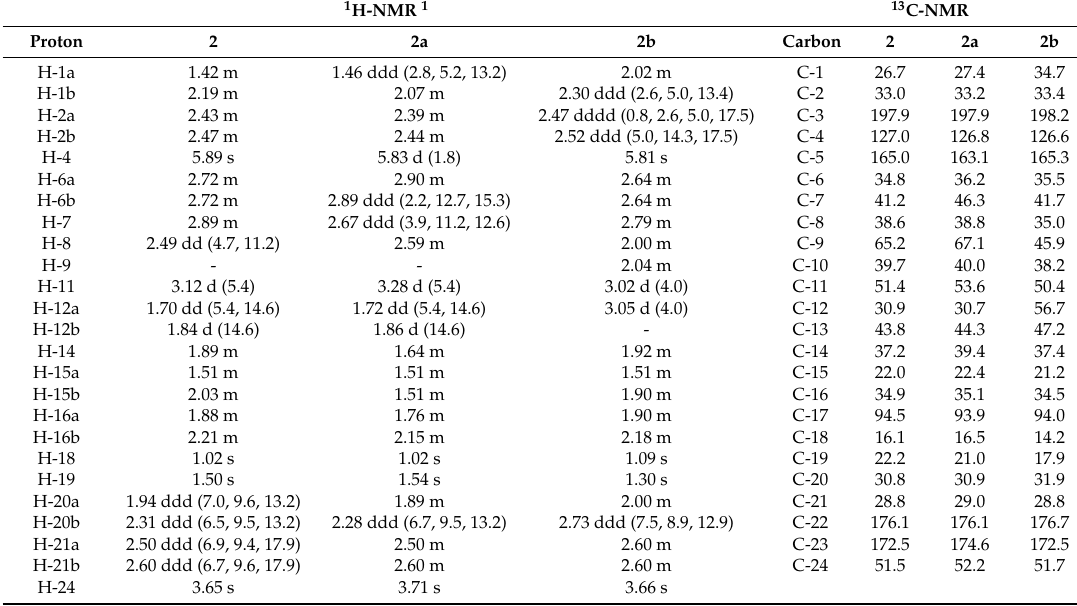
Table 8. 1 H- and 13 C-NMR spectral data for (7 α ,11 α ,17 α )-9,11-epoxyester 2 , (7 β ,11 α ,17 α